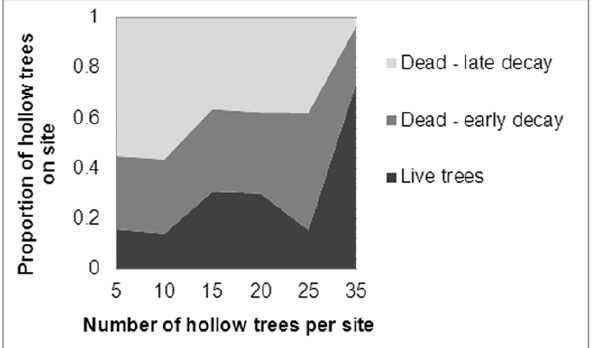
Figure 2. The proportion hollow-bearing trees on each site that are live trees (Tree forms 1–2 in Figure 1), early-decay stage dead trees (Tree forms 3–6) or late-decay stage dead trees (Tree forms 7–8) plotted in relation to the number of hollow- bearing trees per site.